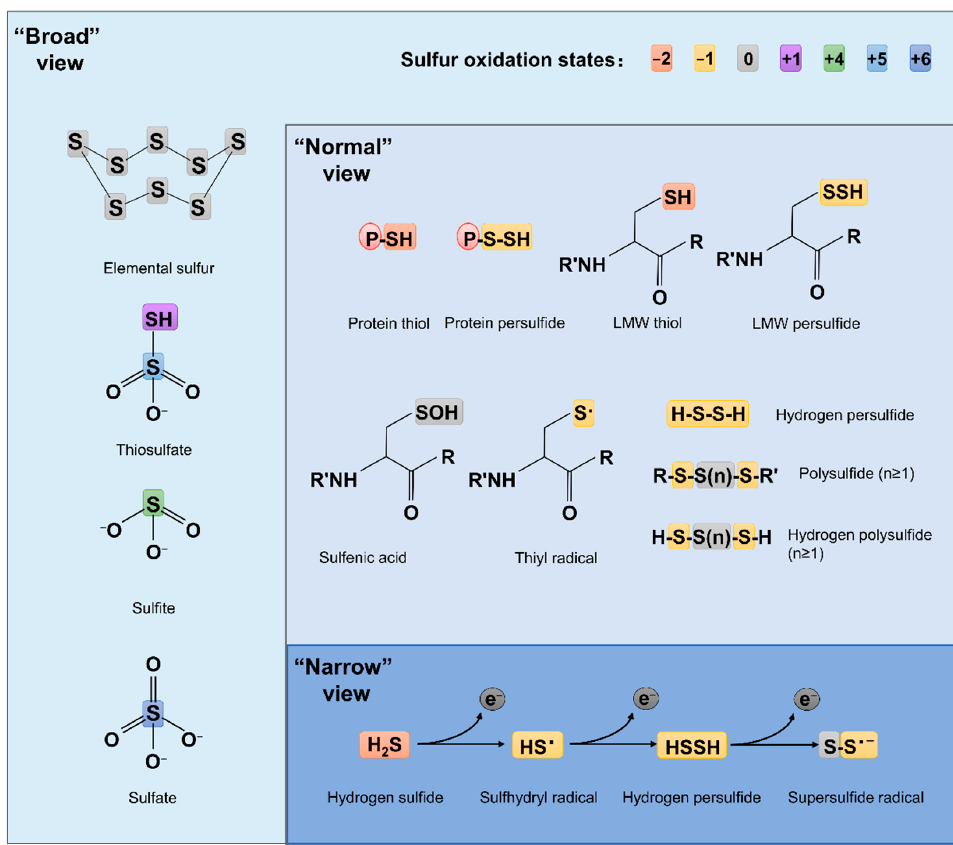
Figure 1. Structures of some RSS chemotypes in different views. The red ( − 2), yellow ( − 1), gray (0), purple (+1), green (+4), light blue (+5) and dark blue (+6) rectangles are used to designate the valence states of sulfur, as specified.